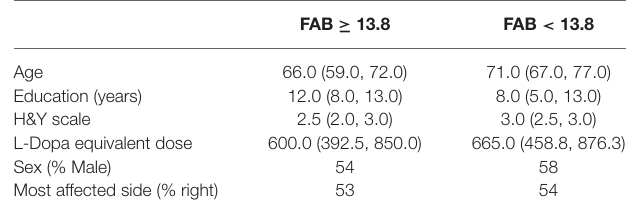
TABLE 2 | Demographical and clinical data of patients subdivided according to